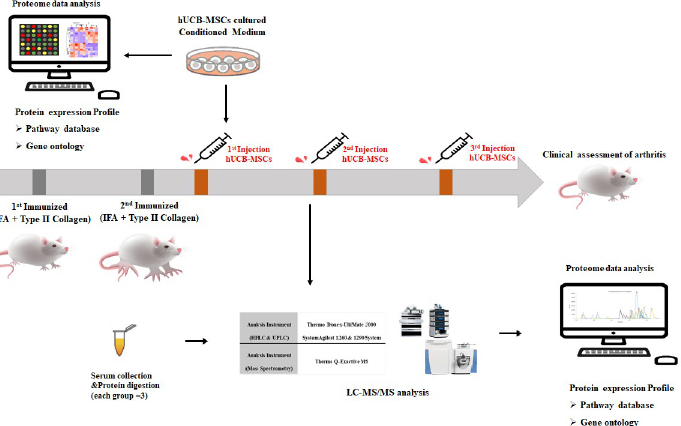
Fig 1. Schematic outline of therapeutic efficacy of hUCB-MSCs on CIA mice model of RA and proteome data analysis by LC–MS/MS and L-1000. Type 2 collagen was injected into mice twice to prepare the CIA mice model (n = 4 for each group). The hUCB-MSCs were injected once a week, for a total of 3 times. For serological analysis (LC-MS/MS analysis), serum was collected by the cardiac blood collection method one week after the first injection of hUCB-MSCs. Clinical assessment was performed until the end of the experiment. In order to analyze factors secreted by hUCB-MSCs, conditioned media of hUCB-MSCs were analyzed by L-1000